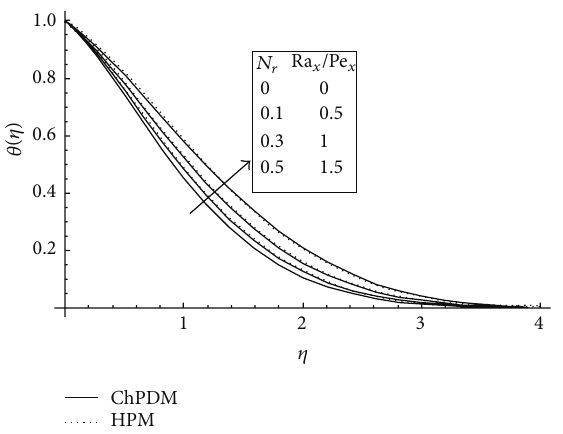
Figure 5: Comparison of ChPDM (solid) and HPM (dotted) for the effect of the Lewis number ( Le ) on the nanoparticle concentration distribution 𝜙(𝜂) at 𝑁 𝑏 = 0.5 , 𝑁 𝑡 = 0.5 , 𝑁 𝑟 = 0.5 , Ra 𝑥 / Pe 𝑥 = 0.5 , and 𝛼 = 𝜋/6